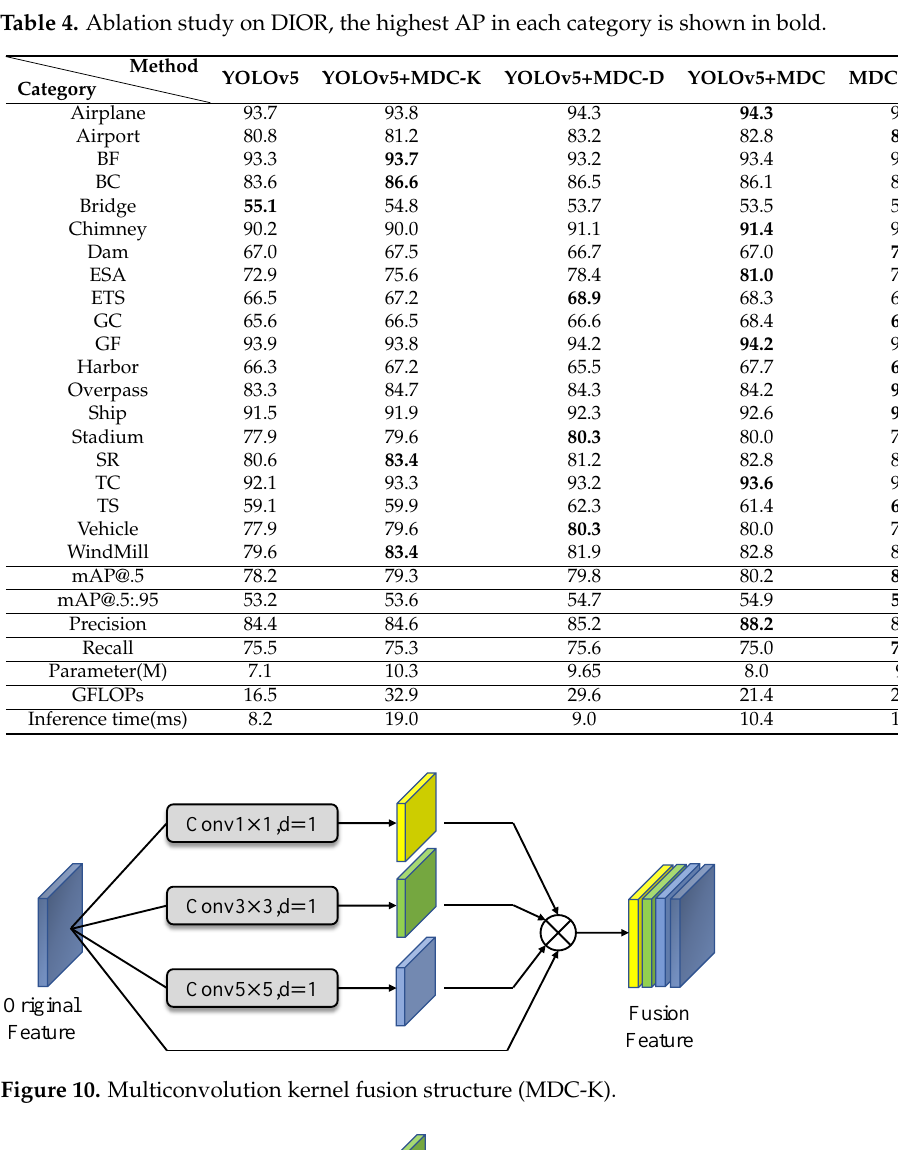
Table 4. Ablation study on DIOR, the highest AP in each category is shown in bold.